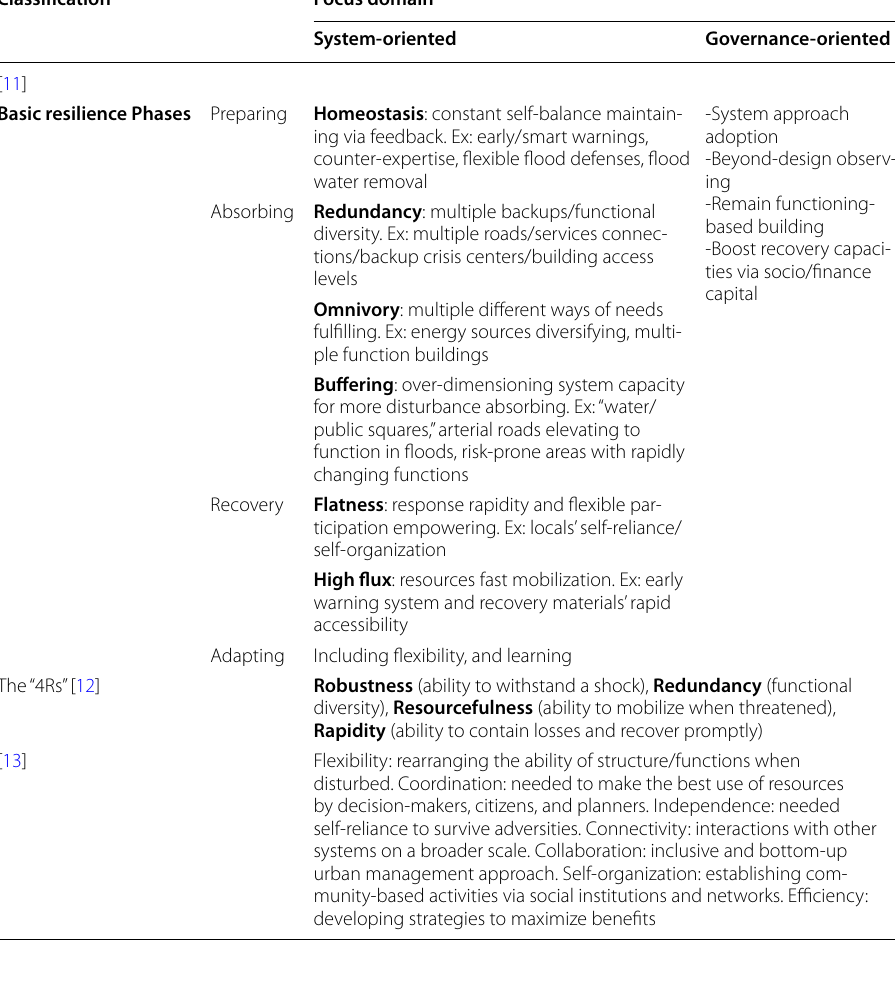
Table 2 Resilience capacities Classification